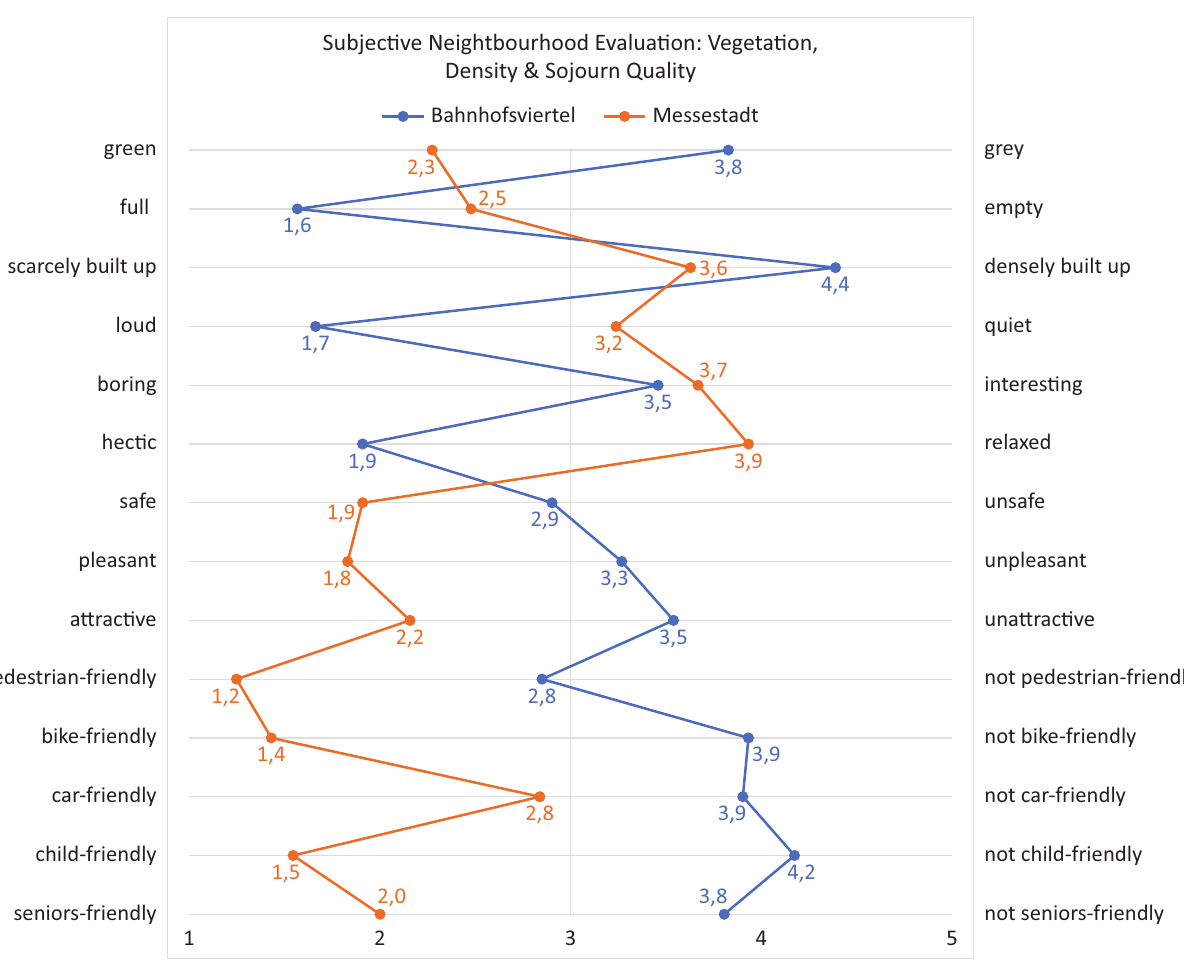
Figure 5. Polarity profile: Subjective evaluation of Bahnhofsviertel (blue) and Messestadt